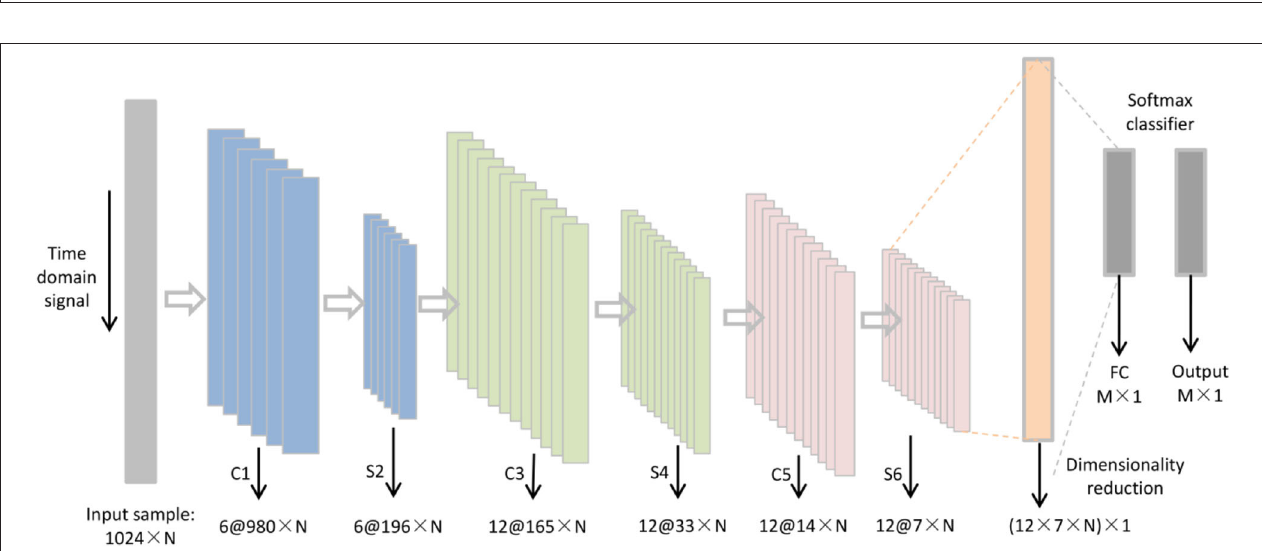
FIGURE 4 | Basic framework of the CNN. Here, C represents a convolution layer, S represents a pooling layer, FC represents the fully connected layer, N represents the number of nodes in the input sample, and M represents the number of nodes in the output.